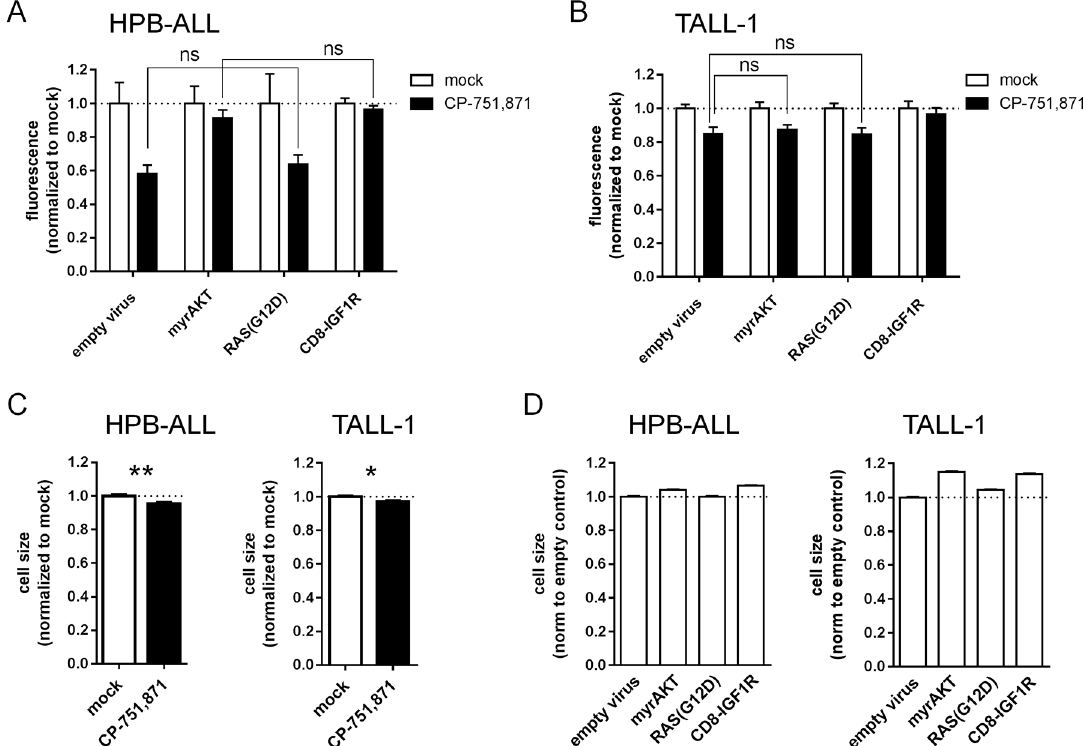
Fig 3. Constitutive activation of AKT, but not RAS rescues T-ALL cells from IGF1R inhibition. ( A,B ) Cell growth as measured by resazurin reduction. T-ALL cells were transduced with lentiviral vectors as indicated, FACS sorted, and then cultured in vitro with IGF1R blocking antibody (1 μ g/ml CP-751,871) for 3 days. Mean resorufin fluorescence values +/- SD after normalization to respective mock-treated controls are plotted for assays performed in triplicate. ns , not significant (2-way ANOVA with Sidak ’ s multiple comparisons test) . ( C,D ) Cell size as measured by forward light scatter. ( C ) T-ALL cells were treated with CP-751,871 (1 μ g/ml) for 3 days. Data are depicted for gated live events. ( D ) T-ALL cells were transduced with lentiviral vectors as indicated. Data are depicted for gated live GFP+ events. Mean forward light scatter values +/- 95% confidence interval are plotted after normalization to mock-treated control cells ( C ) or to untransduced cells in the same culture, then scaled to the empty virus control ( D ). * , p < 0 . 05; ** , p < 0 . 01 (Student ’ s t-test) .